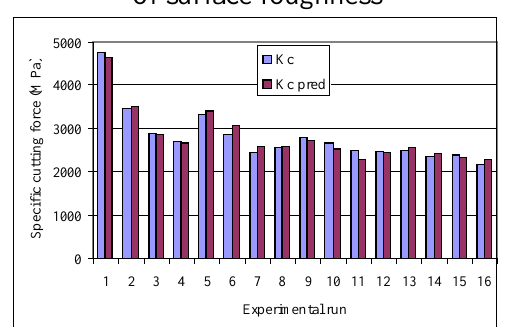
Fig. 4. Experimental and predicted RSM values of cutting force